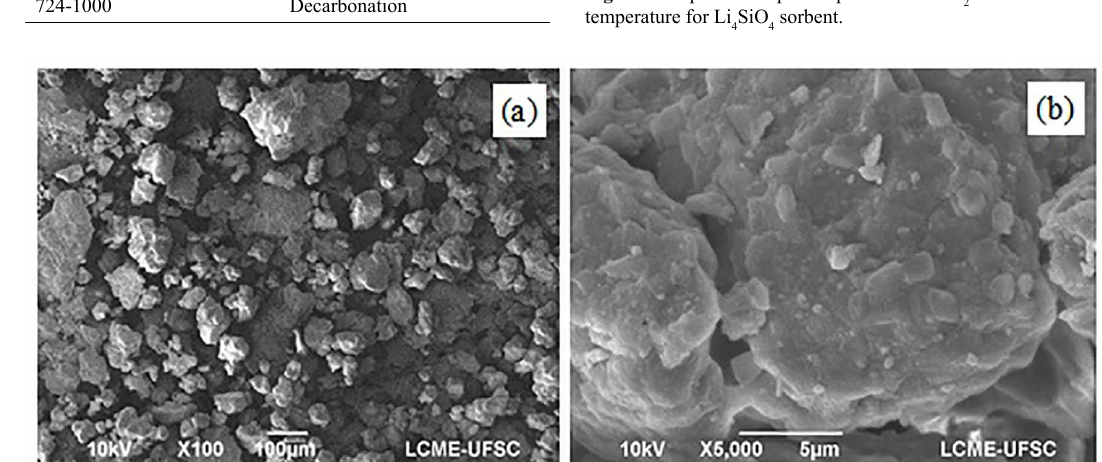
as a function of 2